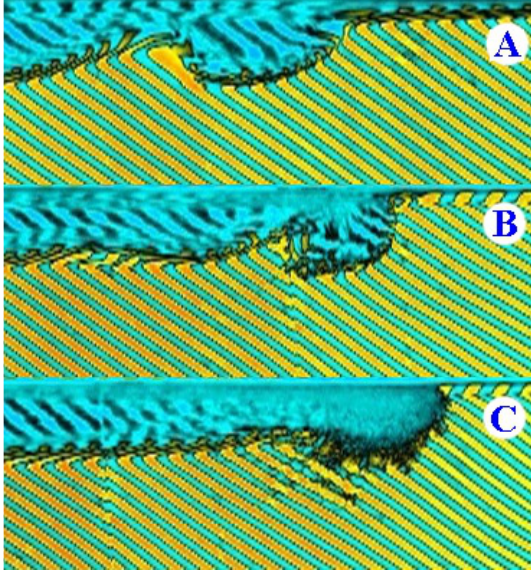
Fig. 3. Transformation of the front of subsurface intrusion: A, B, C are positions of the front corresponding to Fig.